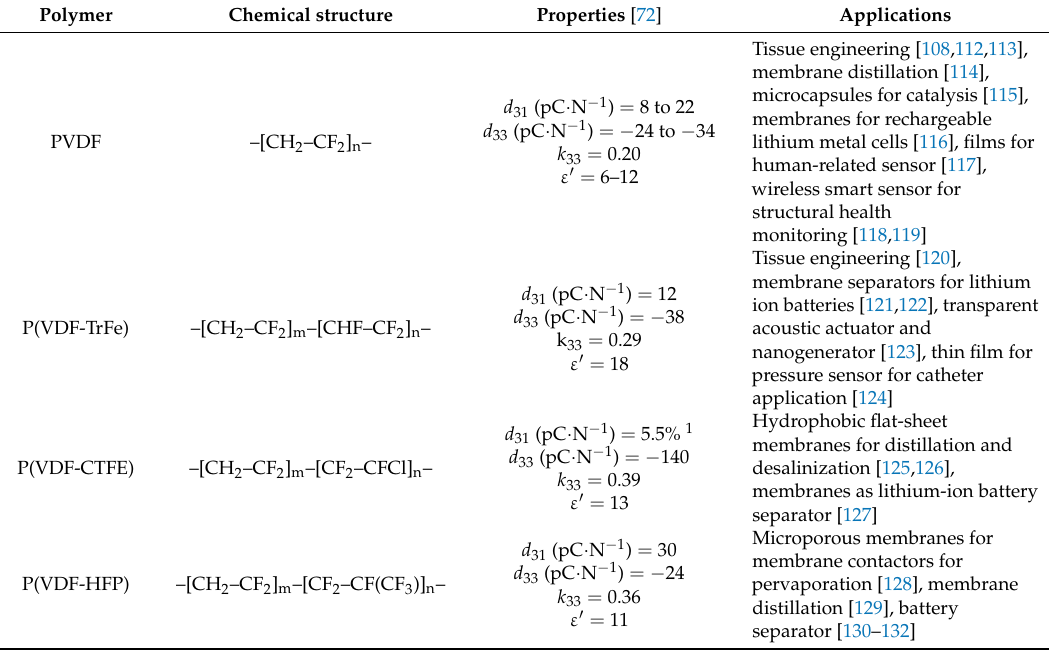
Table 2. Chemical structure of commonly used copolymers, some relevant electromechanical and dielectric properties [72] and their general